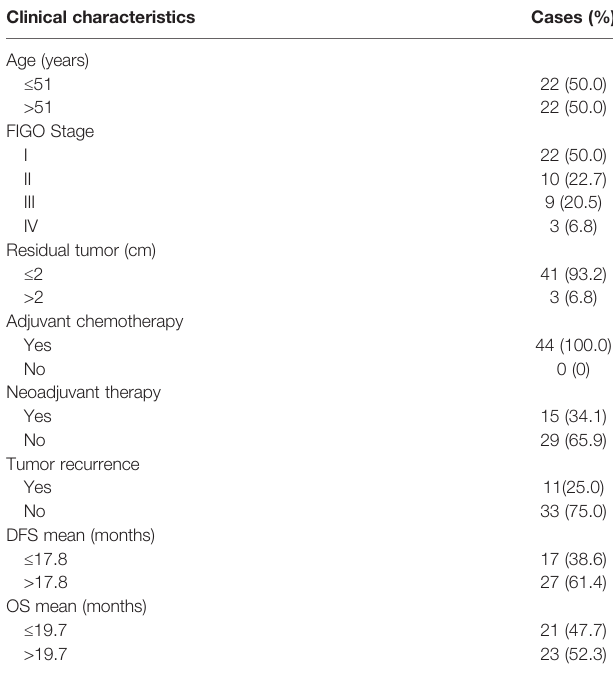
TABLE 1 | Clinical characteristics of forty-four OCCC